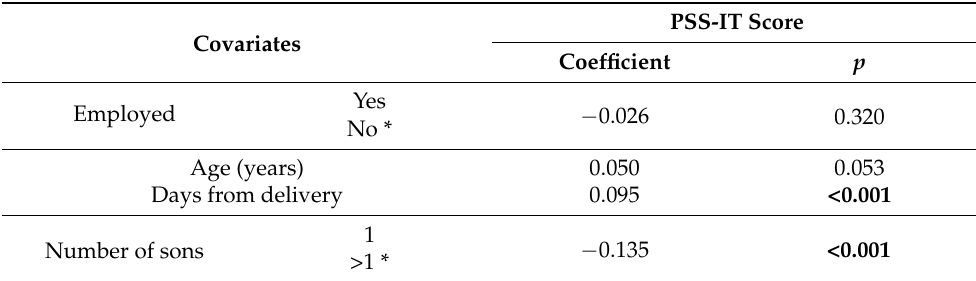
Table 4. Multivariate analysis: linear regression model of PSS-IT